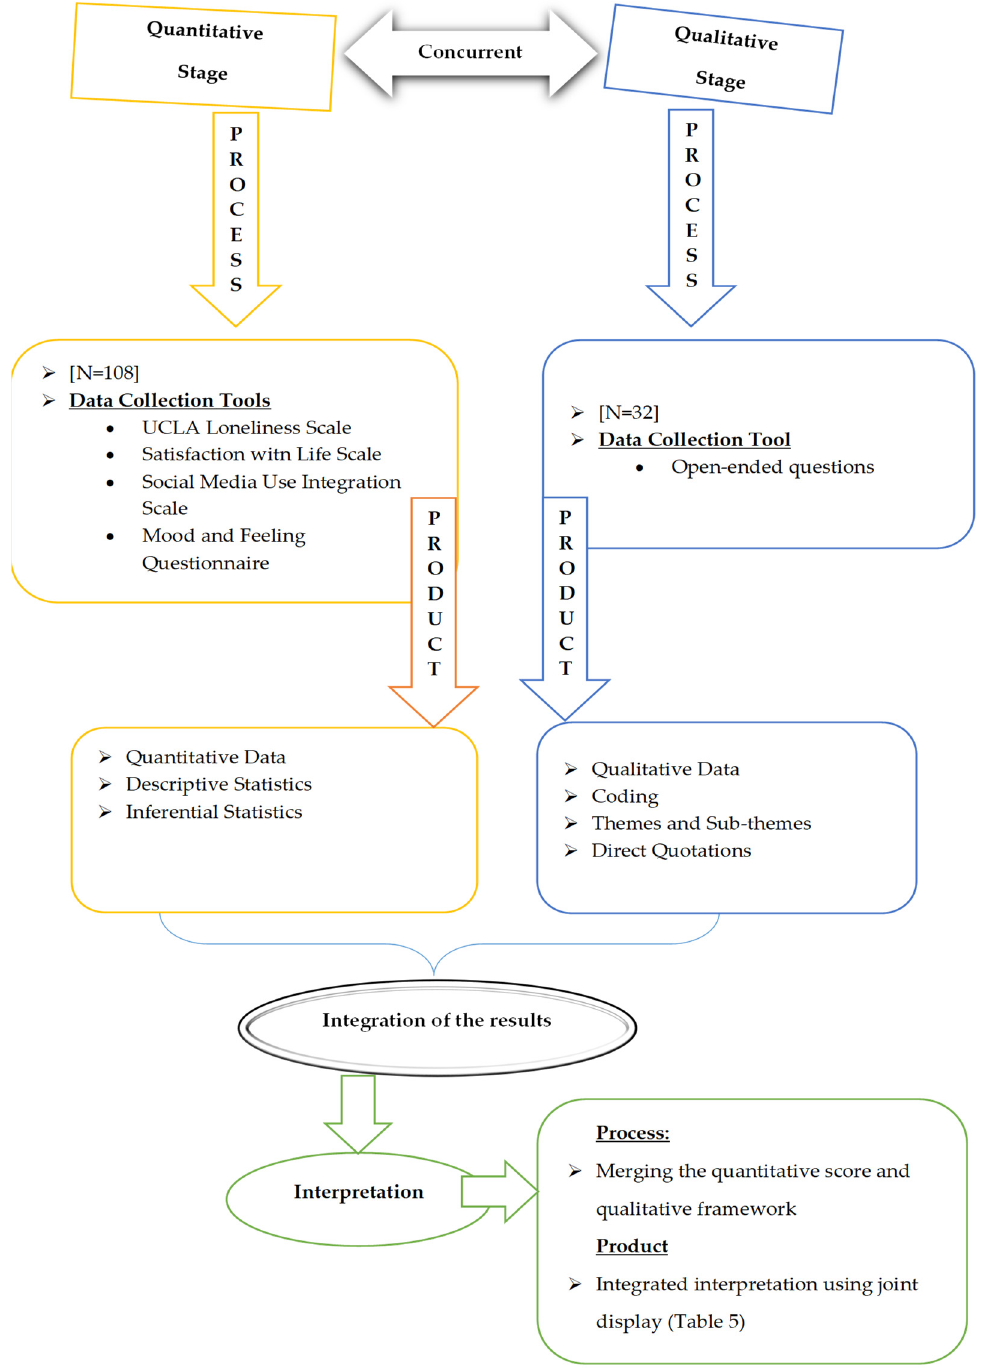
Figure 1. The process diagram of the research.